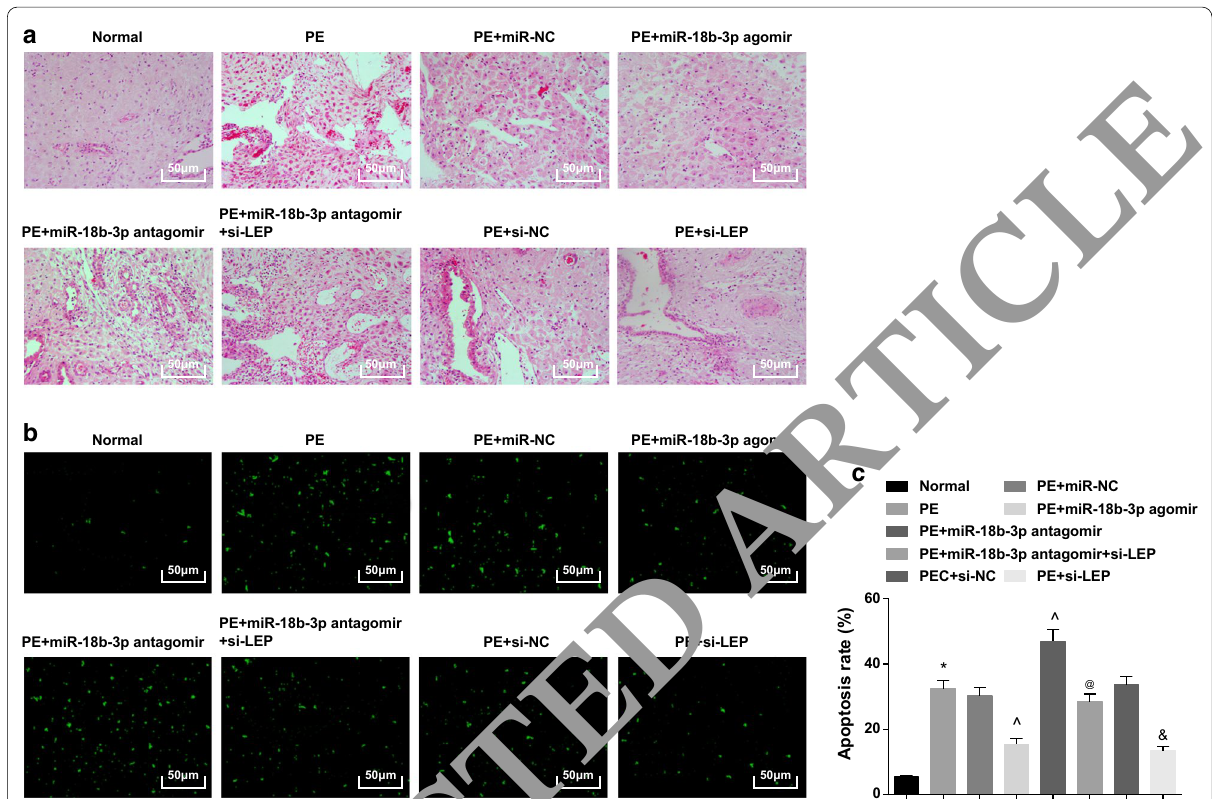
Fig. 3 Overexpressed miR-18b-3p ameliorates pathological change and suppresses apoptotic cells of placenta tissues in PE rats. a HE staining was utilized to test pathological features of placenta tissues. b TUNEL staining was implemented to determine apoptotic cells of placenta tissues in PE rats. c Cell apoptosis rate was detected by TUNEL staining. n 10, * p < 0.05 versus the normal group. ^ p < 0.05 versus the miR-NC group. @ p < 0.05 = versus the miR-18b-3p antagomir group. & p < 0.05 versus the si-NC group. Measurement data were depicted as